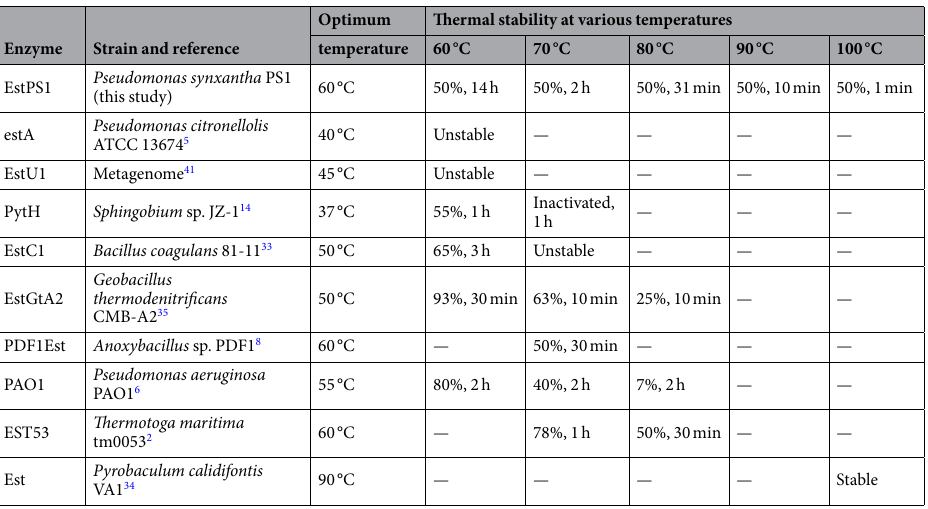
Table 3. Comparison of the thermostability of carboxylesterases at different